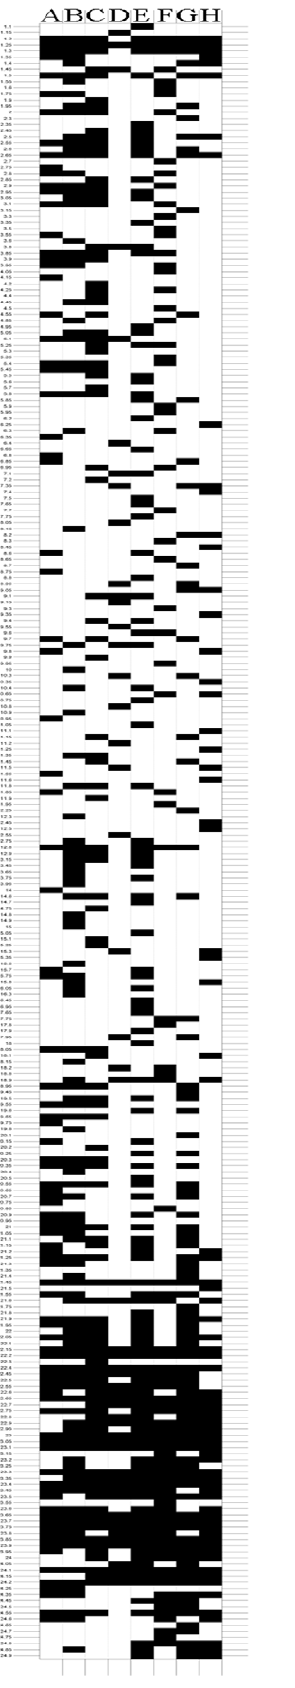
Figure 5. Binary plot illustrating the GC-MS chromatographic peaks (metabolites) associated with each SPME fiber. Columns represent the fibers while rows indicate peak retention times. Each extraction was performed in duplicate and replicates combined. Fiber legend: A - 75 m m CAR-PDMS, B - 85 m m CAR-PDMS, C - 50/30 m m CAR- DVB-PDMS, D - 85 m m PA, E - 65 m m DVB-PDMS, F - 7 m m PDMS, G - 100 m m PDMS, H - 60 m m